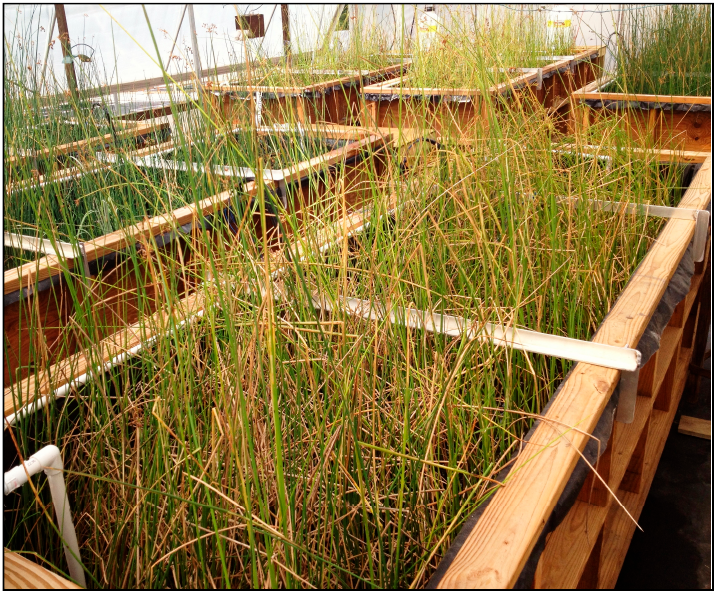
Figure 1. Wetland mesocosm laboratory [34].